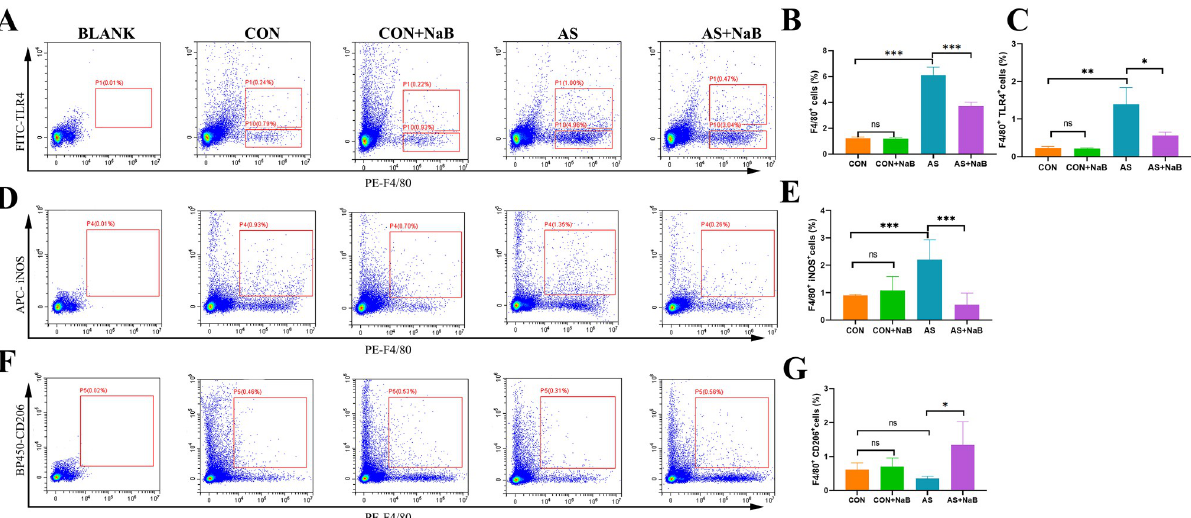
Fig 4. Effects of NaB on M ψ and associated polarization in ApoE − / − mice with AS by flow cytometry. (A) Flow cytometry analysis of aorta F4/ 80 + TLR4 + M ψ s in diverse groups. (B) The proportion of aorta F4/80 + M ψ s. (C) The proportion of aorta F4/80 + TLR4 + M ψ s. (D) Flow cytometry analysis of aorta F4/80 + iNOS + M1 M ψ s in diverse groups. (E) The proportion of aorta F4/80 + iNOS + M1 M ψ s. (F) Flow cytometry analysis of aorta F4/ 80 + CD206 + M2 M ψ s in diverse groups. (G) The proportion of aorta F4/80 + CD206 + M2 M ψ s. � P < 0.05, �� P < 0.01, ��� P < 0.001. ns, no significant difference. All experiments were performed in triplicate. M ψ : macrophage; TLR4: Toll-like receptor 4.